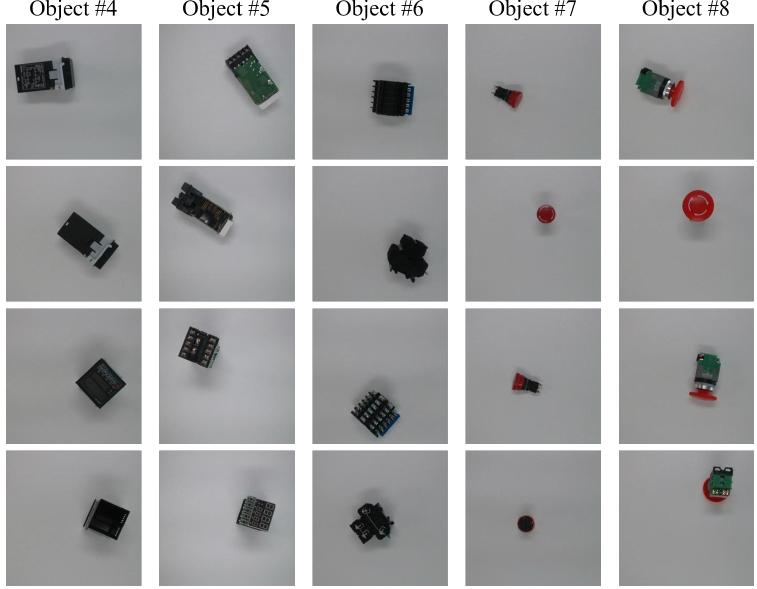
Figure 9. Target objects for image